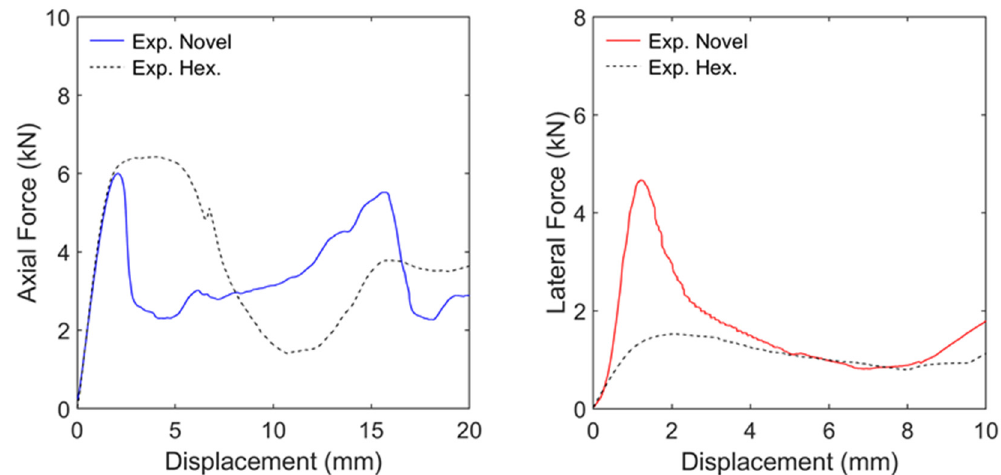
Figure 25. Comparison of load versus displacement curves between novel and hexagonal cells, in the case of both axial force and lateral force. Table 2. Summary of experimental (average) and FE results. FE results are shown in parentheses (). Energy absorption and maximum force are calculated up to a strain of